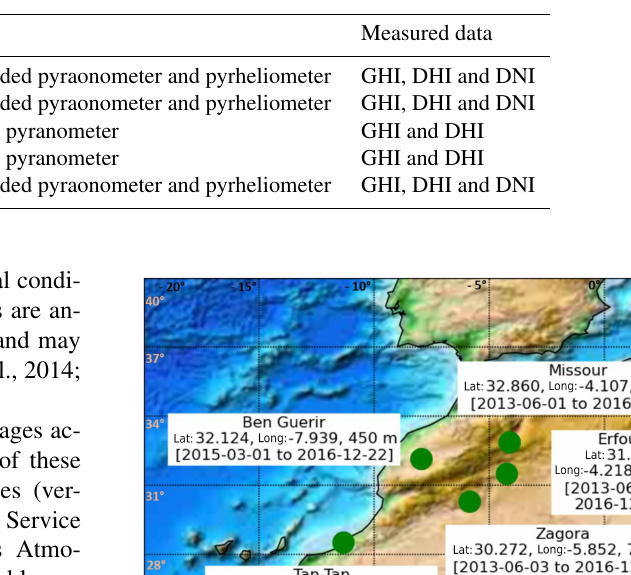
Table 1. Instrument description and measured data for each station (from Schüler et al., 2016).